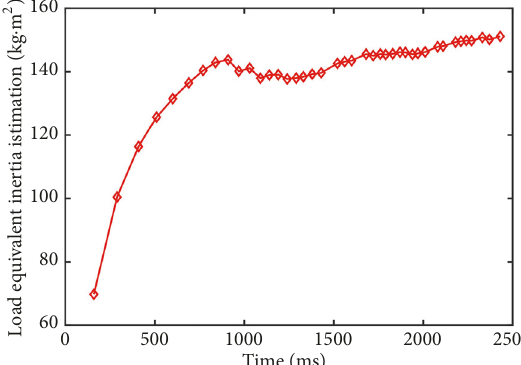
Figure 11: RLSE of the load equivalent inertia during AMT startup under the third gear.